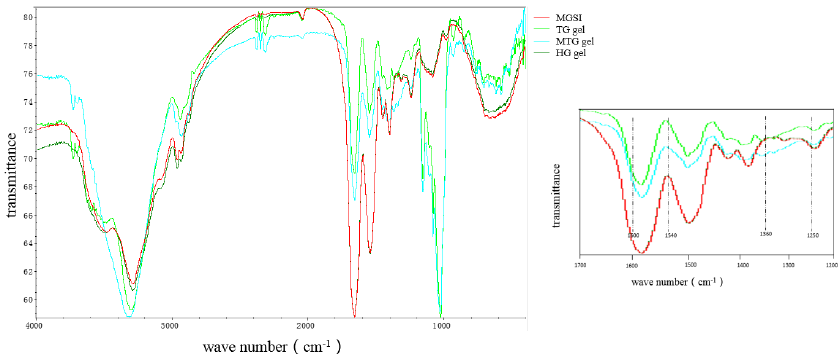
Figure 2. FTIR spectra of different gels.